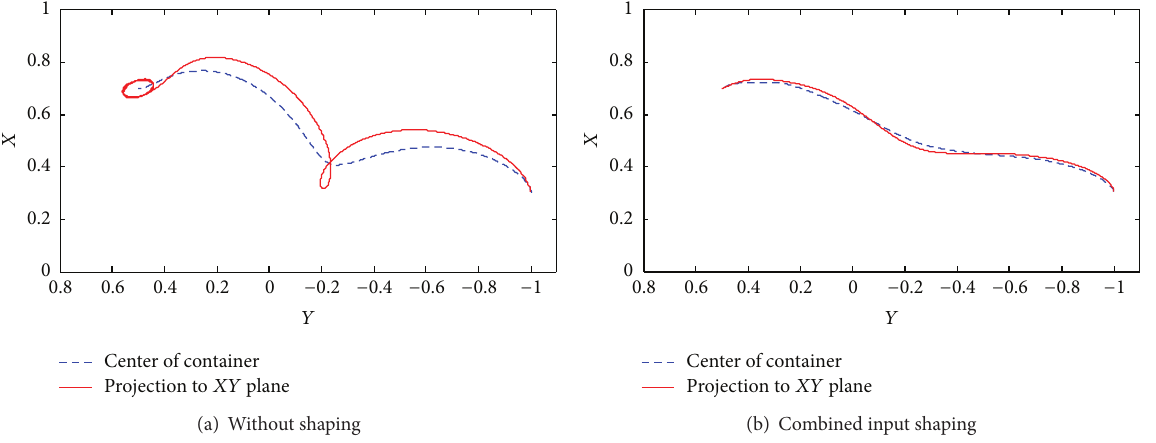
Figure 13: Projection of pendulum bob position in XY plane: (a) without shaping (b) combined input